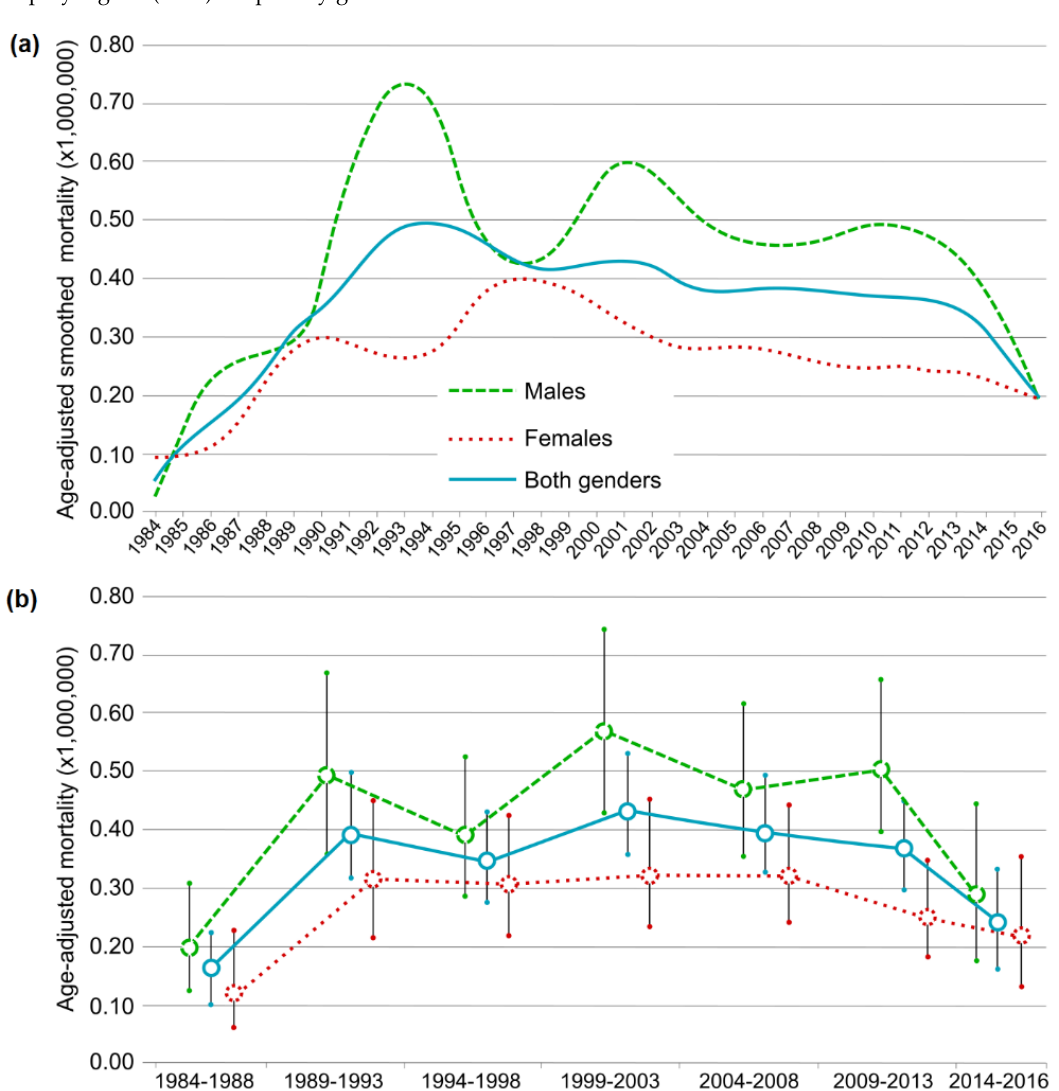
Figure 2. Age-adjusted mortality rates due to GPA in males, females and both genders. ( a ) Annual smoothed rates; ( b ) five-year rates (except for 2014 to 2016), bars show 95% confidence intervals. According to our classification of Spanish municipalities as urban, agro-urban or rural, 16.2% were considered as urban, 2.7% as agro-urban and 81.1% as rural (Table 1). Deaths due to GPA took place in 271 municipalities (3.34% of the total of Spanish municipalities). According to SMR by municipality, 4.57% of agro-urban municipalities had a significantly higher GPA mortality than expected for Spain as a whole, while this percentage was lower in urban and rural municipalities (Table 1). Only one urban municipality obtained a death risk lower than expected (Barcelona: SMR = 0.52; 95% CI = 0.24–0.98). However, global SMR in these categories was similar to the expected value (SMR = 1.00): SMRs due to GPA in all agro-urban areas considered as a whole were 1.25 (95% CI = 0.93–1.64), 0.87 (95% CI = 0.68–1.10) in rural and 1.00 (95% CI = 0.89–1.12) in urban.